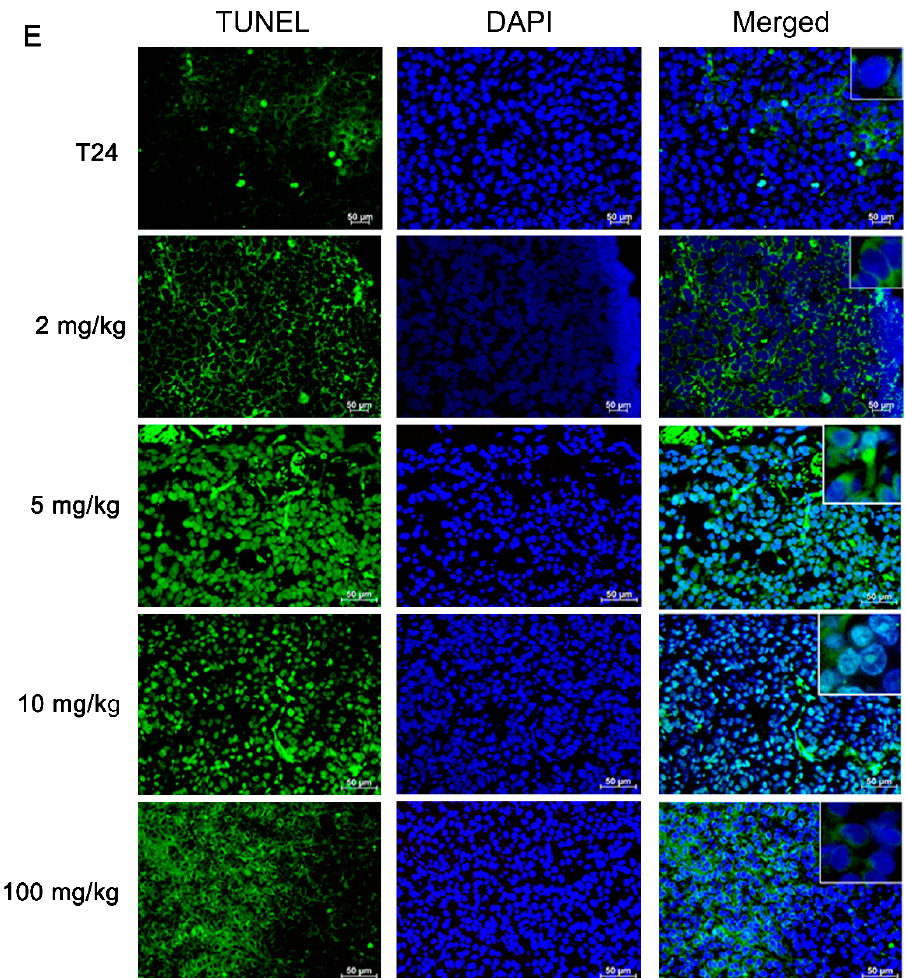
Figure 4. The inhibition of the xenografted UBUC growth in nude mice by the treatment of the EtOAc layer. T24 cells were injected s.c. into nude mice and were o.g. administrated with water (control), 2, 5, 10, or 100 mg/kg EtOAc layer as described in Materials and Methods. ( A ) The body weights of the extract-treated mice. *** p < 0.001, ** p < 0.005; ( B ) The effects of the EtOAc layer on tumor growth in the xenografted nude mice. The volumes of tumors from the extract-fed mice were compared to those of the water-fed mice. *** p < 0.001; ( C ) The tumor weight. The tumor weight was measured at the 10 th week. *** p < 0.001; ( D ) The typical H/E images (400×) of tumor specimens dissected from xenografted nude mice; ( E ) The representative terminal deoxynucleotidyl transferase-mediated deoxyuridine triphosphate nick end-labeling (TUNEL) images (400×) of tumor lesions from xenografted nude mice. H&E and TUNEL assays were performed as described in Material and Methods.